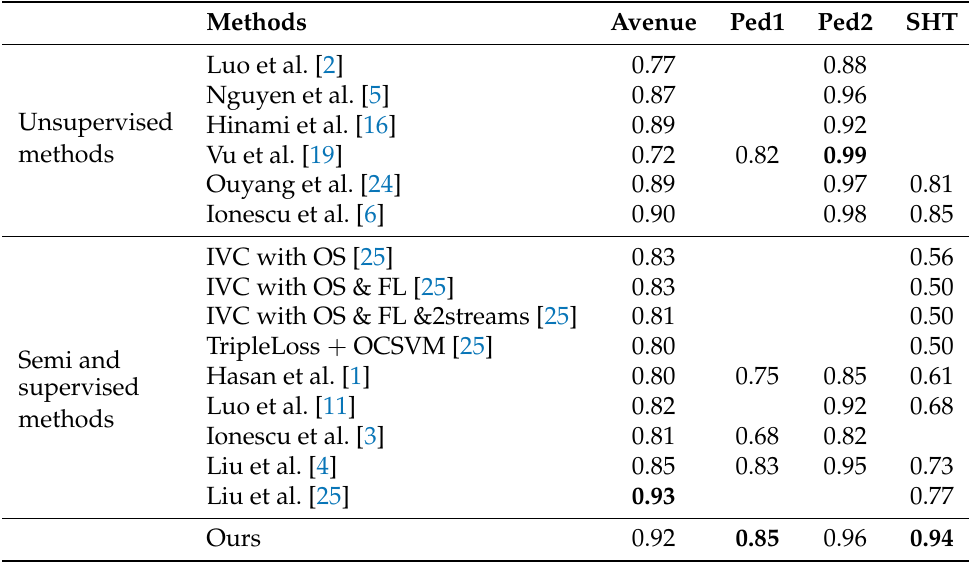
Table 4. Comparison of Frame level AUC on 4 datasets between ours solution and recent state-of-the- art methods that reported their performance on at least 2 similar datasets. The best performance on each dataset is highlighted by bold number. We split those methods in two groups. The upper group contains the fully unsupervised methods without adding extra abnormal samples from original test set to training set. The second group contains the semi-supervised and supervised methods that insert abnormal samples into training set. Generally, it is difficult to comparing the methods in different scenarios, especially in second group, because the number of testing samples is not the same. For our case, all the output channels of our model are used. 80% samples of test set are used for training SVM. SHT =